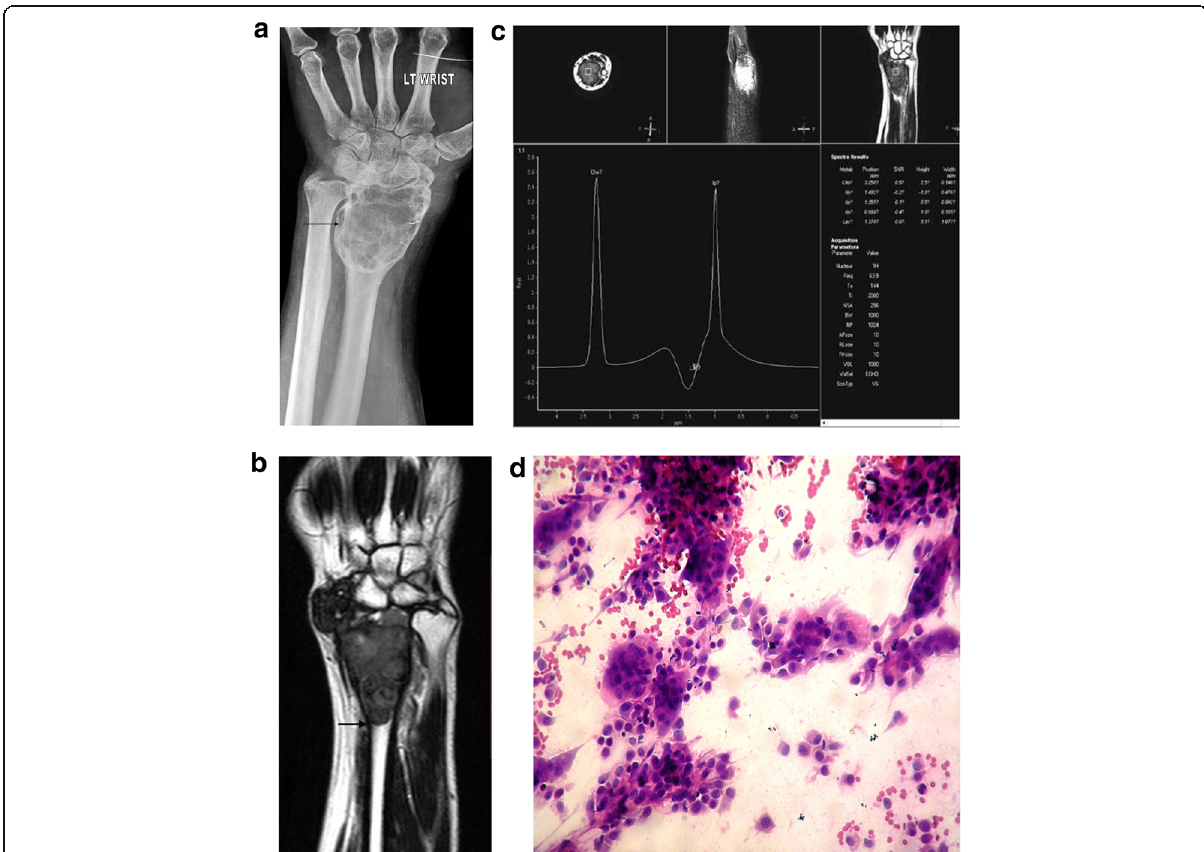
Fig. 7 A30-year-old male patient with pain and swelling left wrist. a Radiograph shows subarticular left distal radial lesion with characteristic soap bubble appearance (arrow) suggestive of GCT. Radial cortex is intact. b The lesion is hypointense on T2-weighted coronal image, with the distinct transition from normal marrow (arrow). c MRS shows a tall choline peak at 3.2 ppm. d HNE 200× shows fragments of neoplastic stromal cells and numerous multinucleate giant cells suggesting